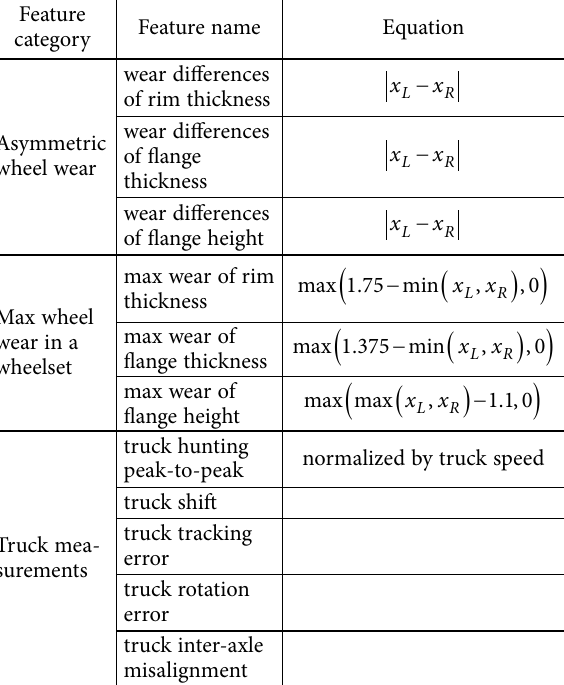
Table 4. Features for identification